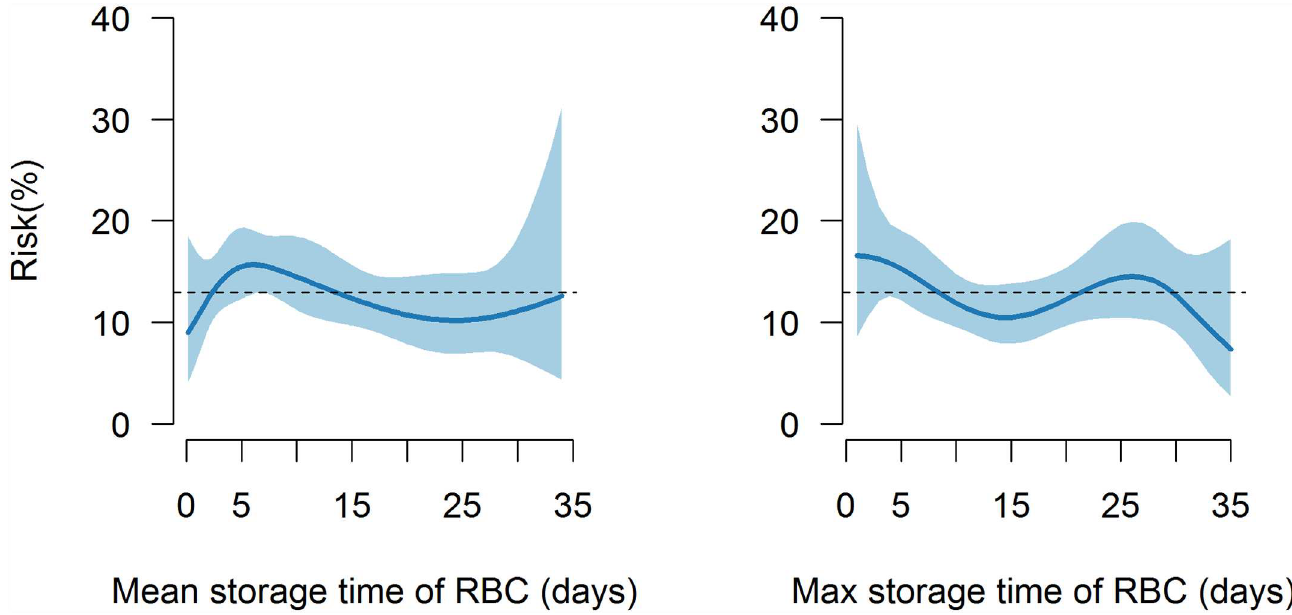
Fig 3. Risk for development of postoperative atrial fibrillation according to storage time of transfused red blood cell units. The baselinerisk (dotted line) represents the risk when receiving1–3 units of RBC, being male gender, being < 60 years of age, receivingno medication( β -blocker, ACE- inhibitor,calcium antagonist), not having COPD or peripheral arteriosclerosis and when having a combinedsurgery as the surgery type.